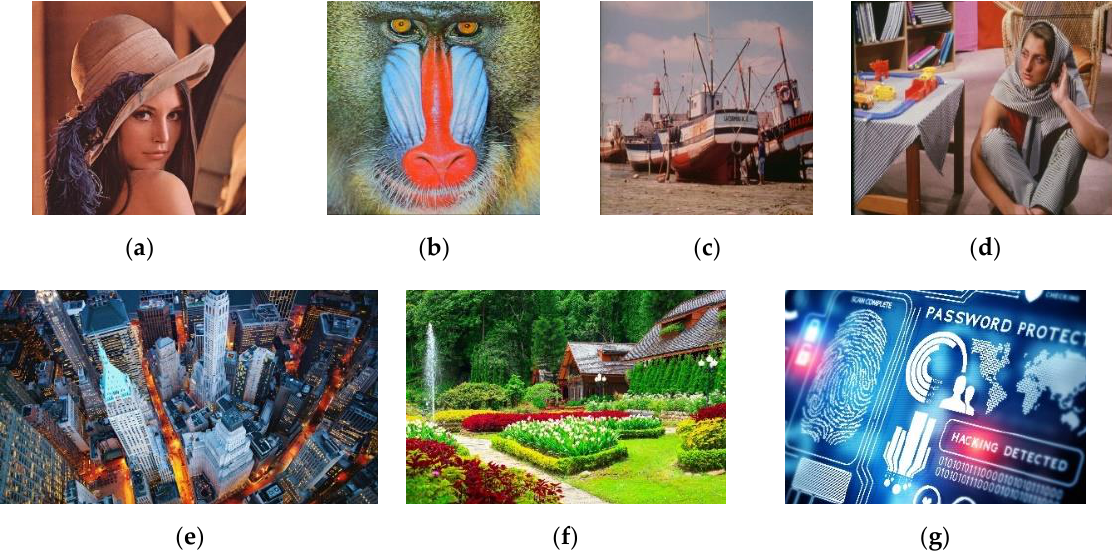
Figure 3. Images for tests: ( a ) Lena.jpeg, ( b ) Babbon.jpeg, ( c ) Boat.jpeg, ( d ) Barbara.jpeg, ( e ) City.jpeg, ( f ) House.jpeg, ( g ) Security.jpeg.